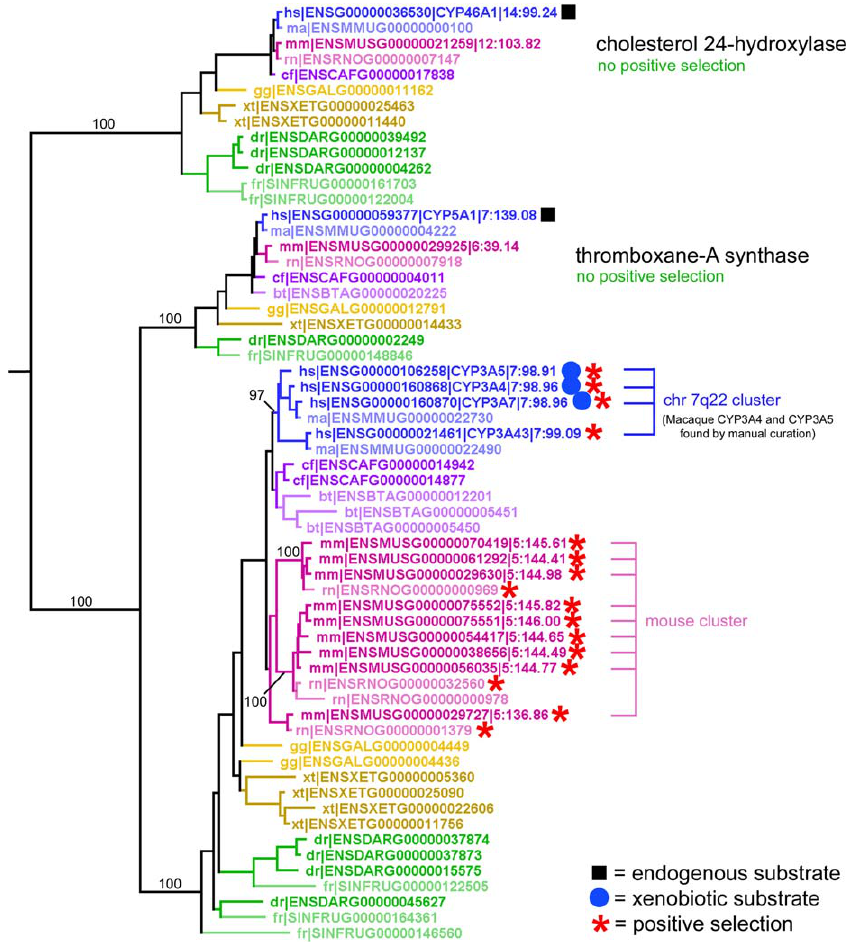
Figure 1. Excerpt from Tree of Vertebrate CYP450 Proteins Shown is one segment of 61 proteins from a maximum-likelihood protein tree of all 628 CYP450 proteins from 10 vertebrate species. The complete tree is shown in Figure S1. Protein names are color coded by species and include a genus-species prefix (e.g., ‘‘ hs ’’ is H. sapiens ). Human and mouse protein names end with the chromosome and position (in Mb) of the corresponding gene. Solid black squares mark human proteins with a known endogenous substrate. Solid blue circles mark human proteins with known xenobiotic substrates. Red asterisks mark genes for which positive selection was detected; tests for positive selection were performed only on primate and rodent genes. Other markings indicate enzyme activity, gene clusters in human (blue), and mouse (pink), and specific groups tested where positive selection was not found (green). Numbers on tree branches show percent bootstrap support for all branches important for interpretation. Almost half of the missing cow CYP46A1 ortholog is present in the Btau3.1 assembly based on a TBLASTN search (Chromosome 21, plus strand at ; 58.4 Mb) (see Table S1). Though not apparent from this tree segment, clear expansions in the number of CYP450 genes are present on other parts of the complete tree for fish, frog, and chicken (Figure S1).